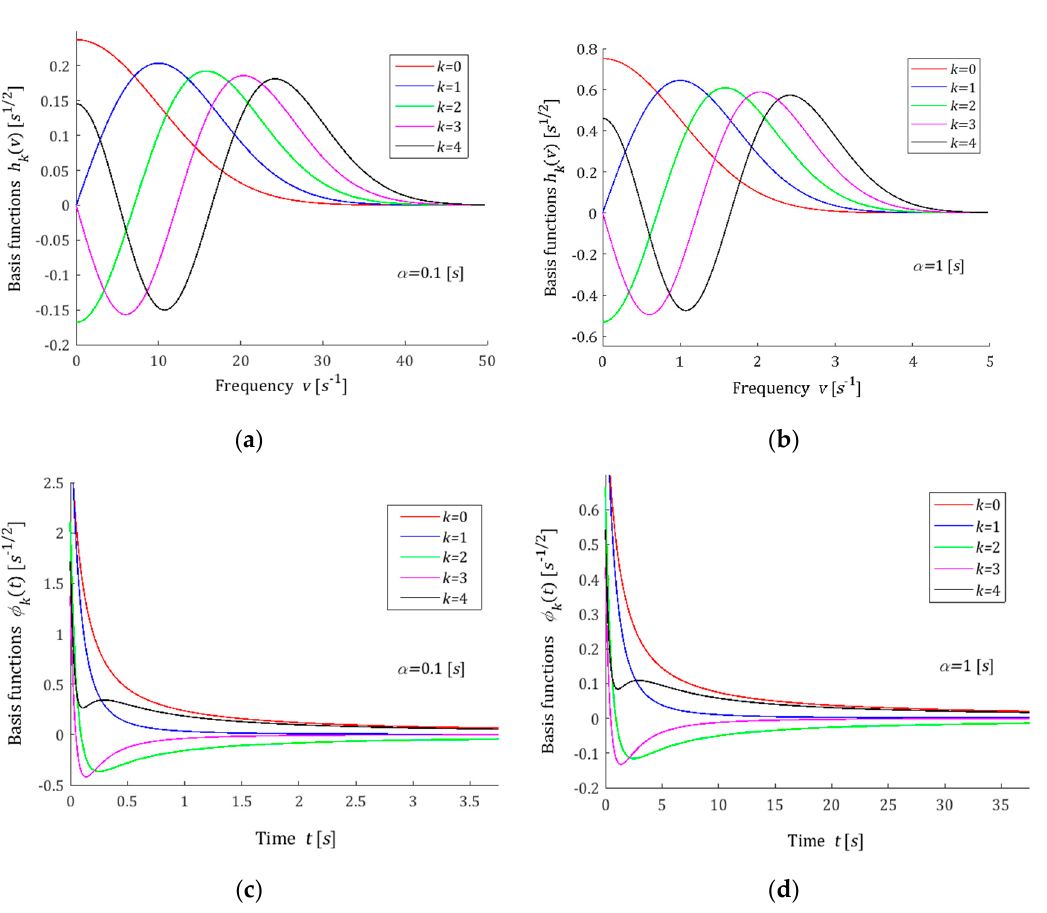
Figure 4. Basis functions ℎ (cid:3038) (𝑣) (44) and 𝜙 (cid:3038) (𝑡) (47)-(49) of the Hermite model for two time-scal- ing factors: ( a ) ℎ (cid:3038) (𝑣) , 𝛼 = 0.1 [𝑠] ; ( b ) ℎ (cid:3038) (𝑣) , 𝛼 = 1 [𝑠] ; ( c ) 𝜙 (cid:3038) (𝑡) , 𝛼 = 0.1 [𝑠] ; ( d ) 𝜙 (cid:3038) (𝑡) , 𝛼 = 1 [𝑠] ; factors: ( a ) h k ( v ) , α = 0.1 [ s ] ; ( b ) h k ( v ) , α = 1 [ s ] ; ( c ) φ k ( t ) , α = 0.1 [ s ] ; ( d ) φ k ( t ) , α = 1 [ s ] ; k = 𝑘 = 0,1,2,3,4 .